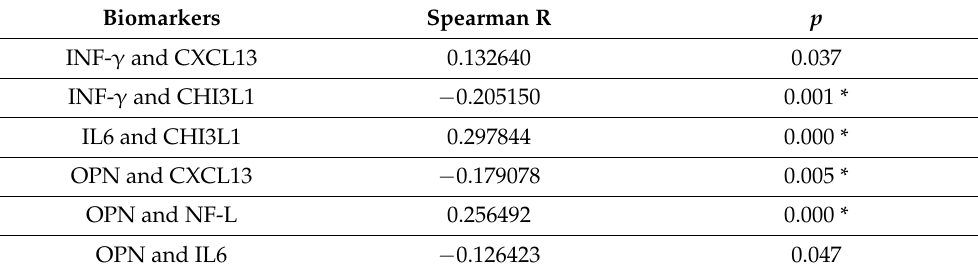
Table 3. Relationships between CSF